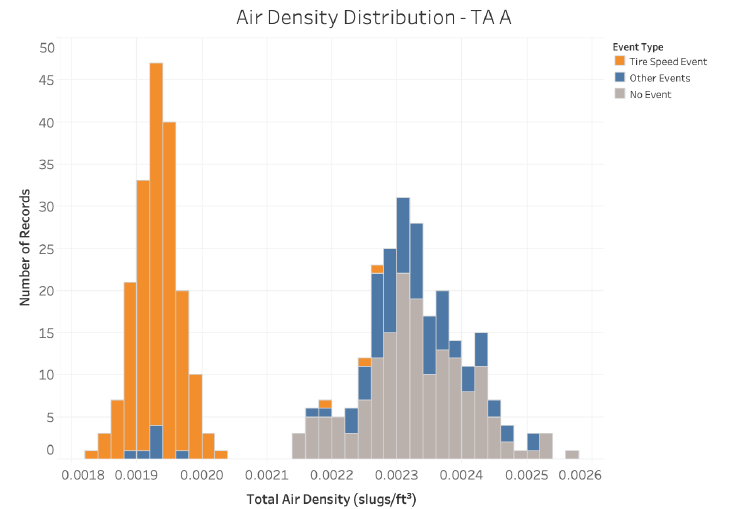
Figure 10. Air density distribution for twin-aisle airframe A